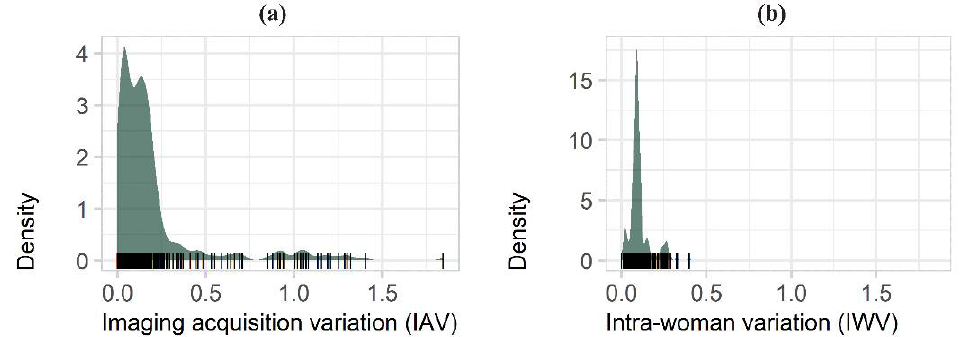
Figure 3. Summary of IAV and IWV results for all 341 features. ( a ) Histogram of IAV scores, with the long tail of features that are highly sensitive to imaging physics; ( b ) Histogram of IWV scores (this shows no such long tail).